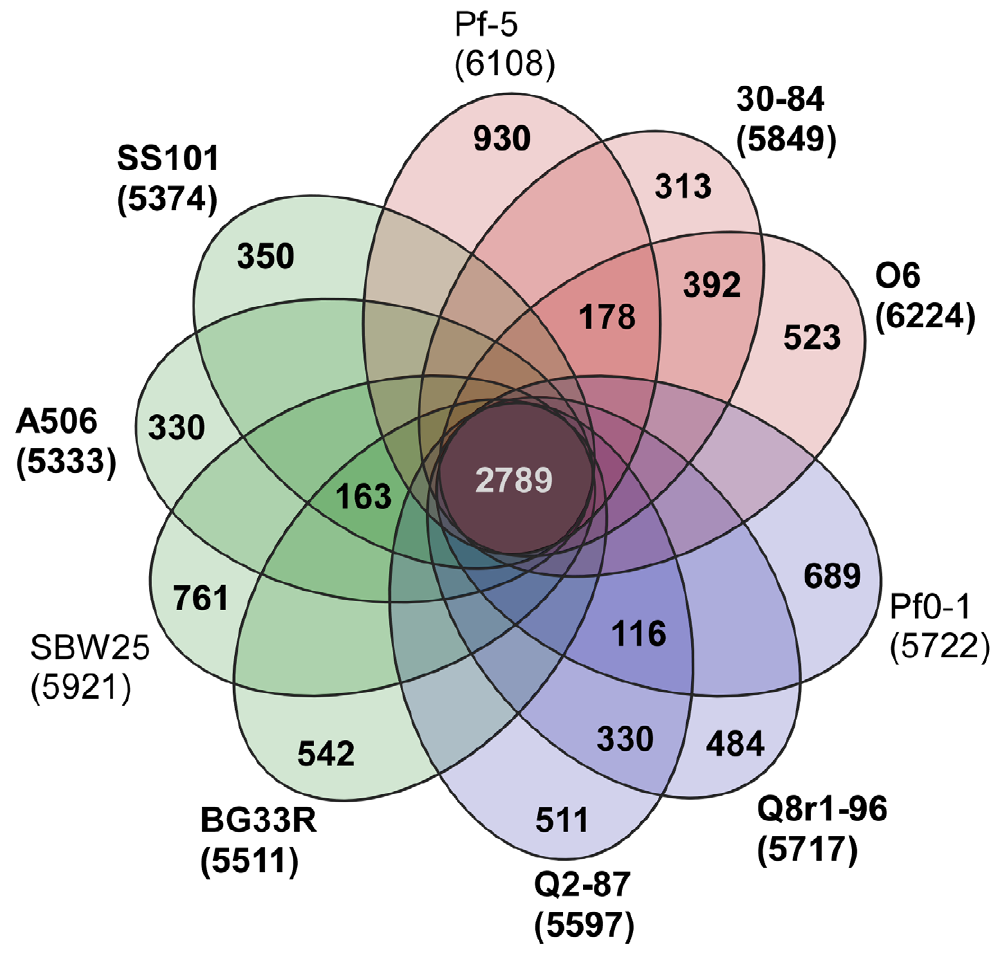
Figure 2. Genomic diversity of strains in the P.fluorescens group. Each strain is represented by an oval that is colored according to sub-clade (as in Figure 1). The number of orthologous coding sequences (CDSs) shared by all strains (i.e., the core genome) is in the center. Overlapping regions show the number of CDSs conserved only within the specified genomes. Numbers in non-overlapping portions of each oval show the number of CDSs unique to each strain. The total number of protein coding genes within each genome is listed below the strain name. Strains sequenced in this study are in bold font.